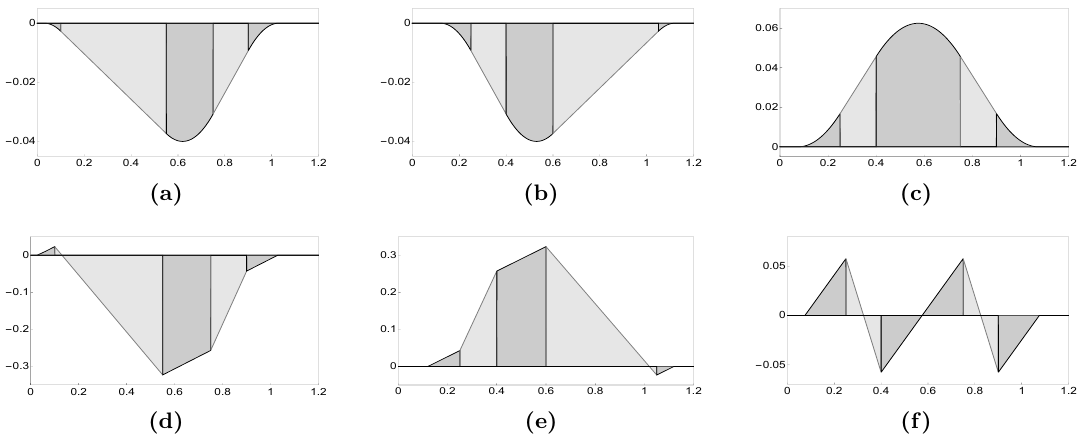
Figure 3 . The pro(cid:12)le function (cid:30) ( t 0 ; x 0 ; v ) of the generalized exact oscillon for v = 0 : 3 at (a) t 0 = 0 : 1, (b) t 0 = 0 : 4 and (c) t 0 = 0 : 75. The corresponding time derivatives of @ t 0 (cid:30) ( t 0 ; x 0 ; v ) are shown in (d) at t 0 = 0 : 1, in (e) at t 0 = 0 : 4 and in (f) at t 0 = 0 :